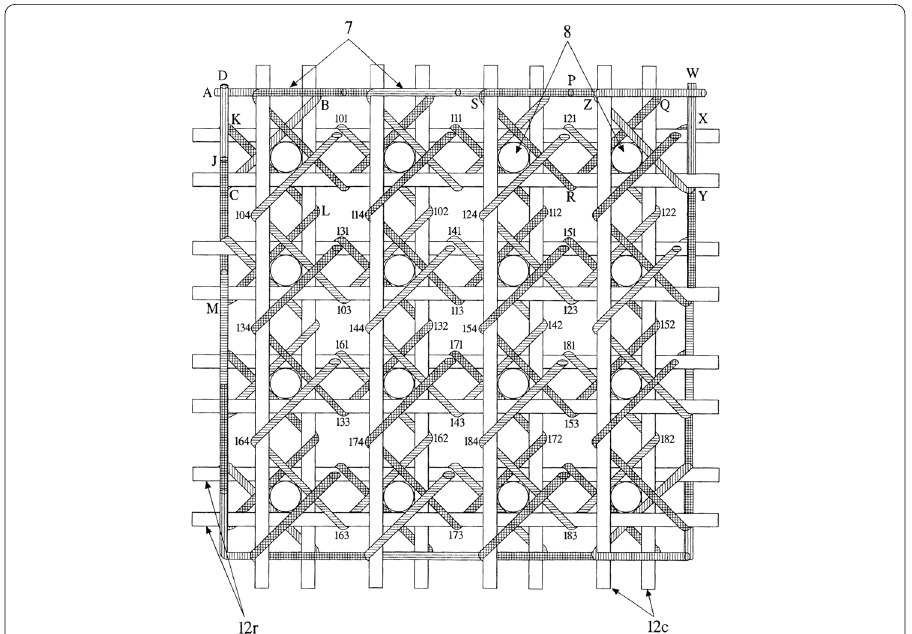
Fig. 8 Fully interlaced 3D woven structure produced by the linear–angular method (Khokar 2002c). 7-active warp yarns, 8-passive warp yarns, 12c,12r-wefts, 101–104, 111–114, 121–124, 131–134, 141–144, 151–154,